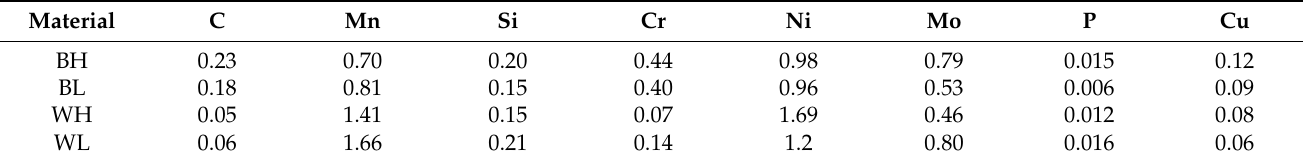
Table 1. Bulk composition in mass% (balance Fe).